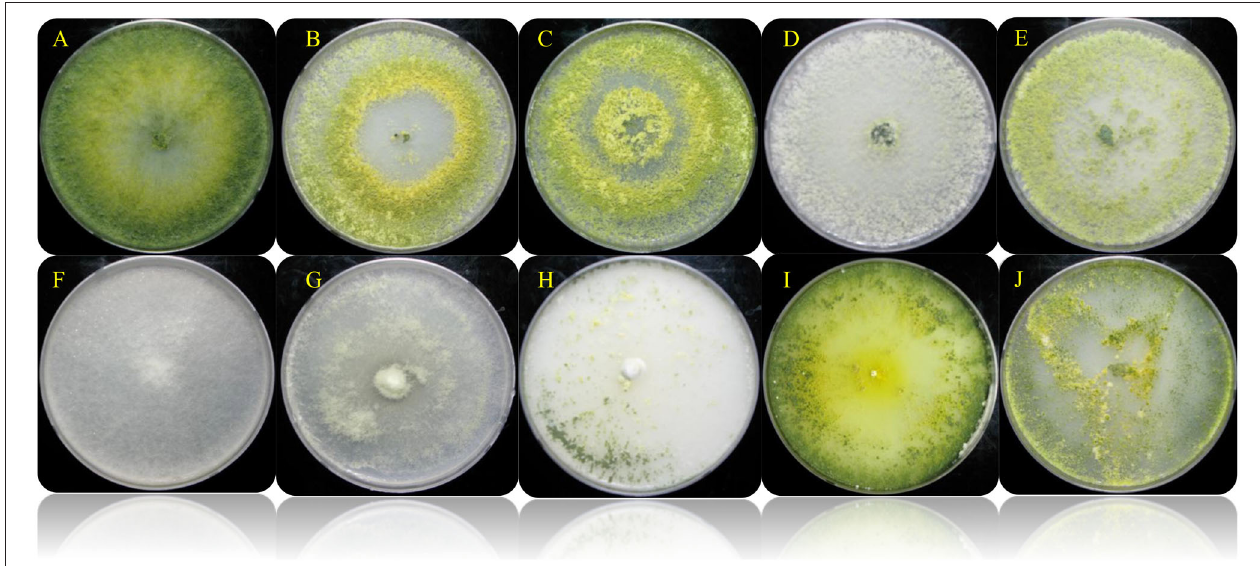
FIGURE 1 | Colony appearance of the different selected Trichoderma spp. isolates on PDA (7 days). (A) Trichoderma harzianum KNU1; (B) T. reesei KNU4; (C) T. harzianum KNU10; (D) T. harzianum H22; (E) T. atroviride 24; (F) T. koningii 27; (G) T. virens 19; (H) T. longibrachiatum 28; (I) T. Pleuroticola P22; (J) T. asperellum 18.